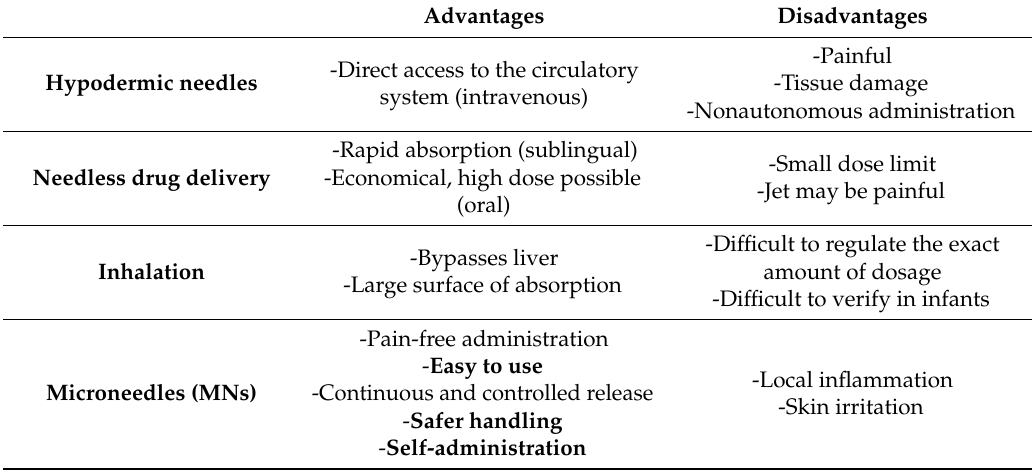
Table 1. Comparison table of di ff erent drug delivery